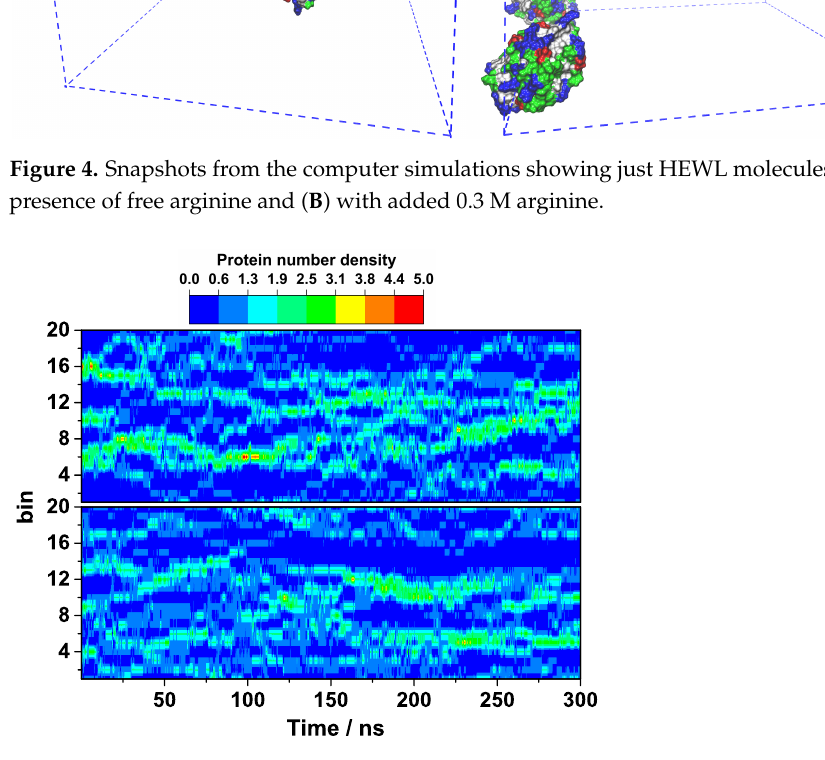
Figure 5. Density fluctuation of HEWL without ( top ) and with ( bottom ) added arginine in the x-axis